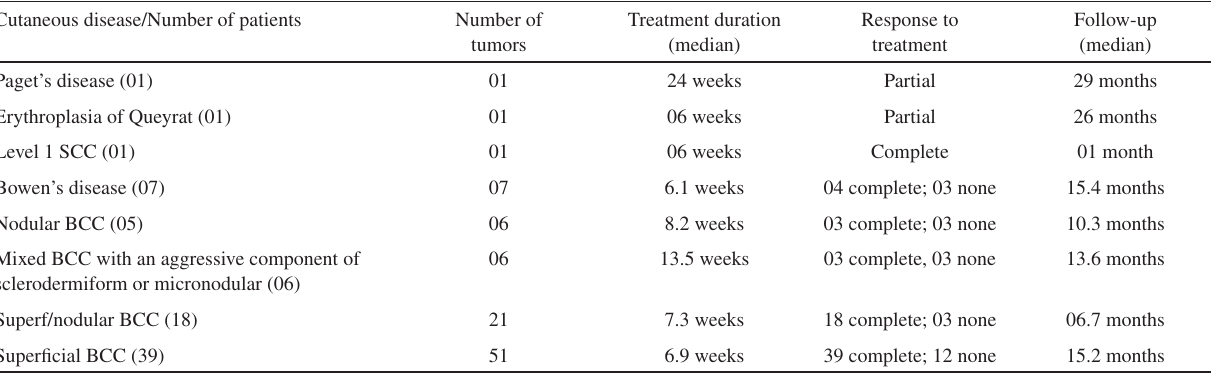
Table 2 - Usage of topical 5% imiquimod cream in patients without comorbidities Cutaneous disease/Number of patients Number of